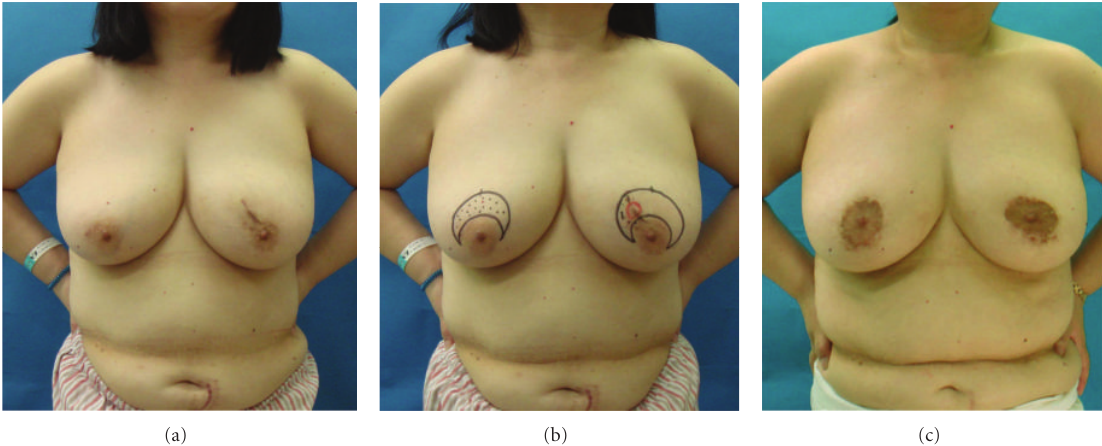
Figure 1: Case 1 . A 51-year-old patient with a T1 tumor in the upper-inner area of her left breast. (a) Bilateral ptotic breasts with the nipple-areola complex (NAC) located beneath the inframammary line. The surgical scar produced by the excisional biopsy was located at the 11 O’clock position of her left breast. (b) Cystic degeneration caused by the excision biopsy was detected by ultrasonography. Periareolar mammaplasty was planned. (c) Postoperative 18 months.